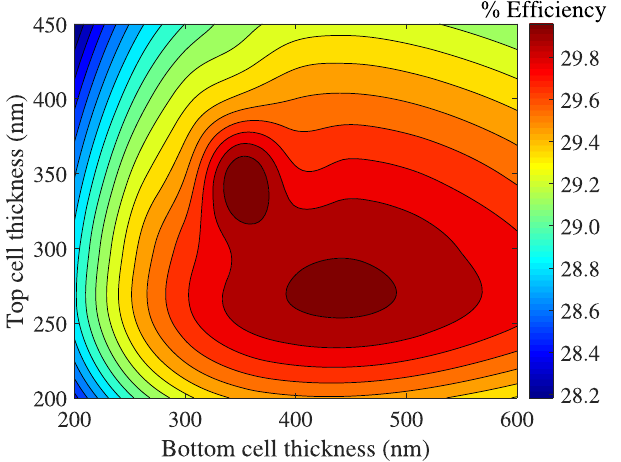
Fig. 11. 4T tandem solar cell ef fi ciency for different thicknesses of top and bottom cells considering trap-assisted recombination losses. The top and bottom cell bandgaps are fi xed at 1.55eV and 1.0eV, respectively. Traps are considered in the interface buffers and the bulk perovskite fi lm of both the subcells.